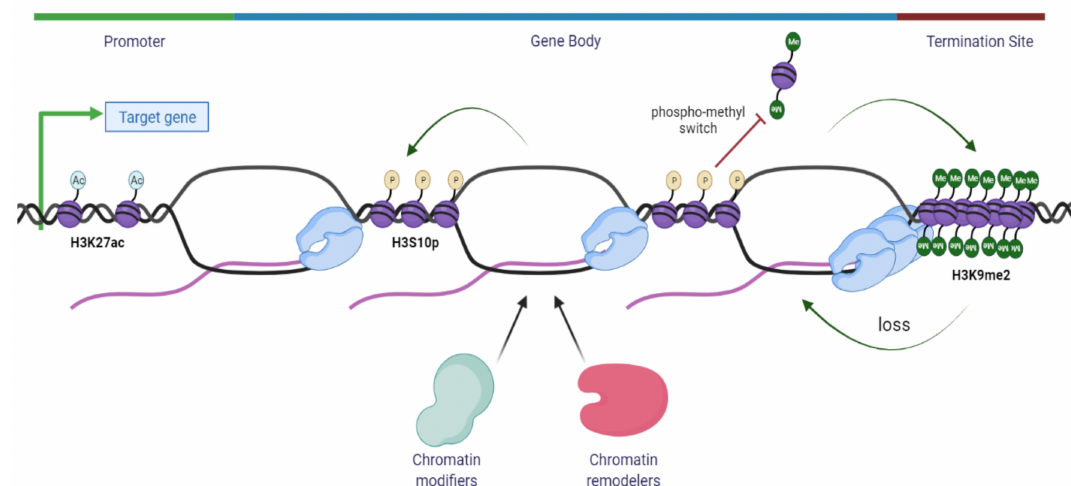
Figure 3. Summary of chromatin modifications associated with the R-loops. R-loops accumulate at the promoter region of genes and are usually associated with an open chromatin structure characterized by H3 acetylation marks, such as H3K27ac and other permissive epigenetic modifications, allowing gene expression and transcription initiation. At terminators, R-loops are formed to induce transcription termination at sites with paused RNAPII, and these R-loops induce the activity of EHMT2/G9a methyltransferase to compact the chromatin by depositing the heterochromatin H3K9me2 mark. Moreover, R-loops are also associated with a closed chromatin architecture that induces repressive marks, such as H3S10p, that might act as a platform for chromatin modifiers and remodelers to alter the chromatin landscape. The antagonism between H3S10p and H3K9me2 prevents the spread of heterochromatin regions across the